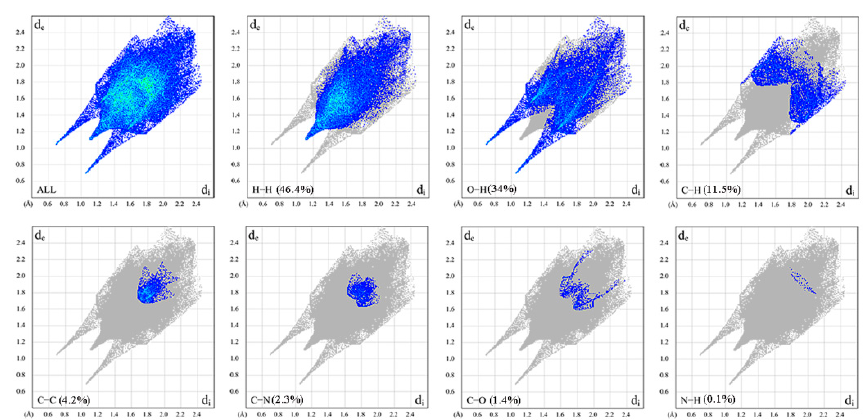
Figure 9. The 2D fingerprint maps for HMD.